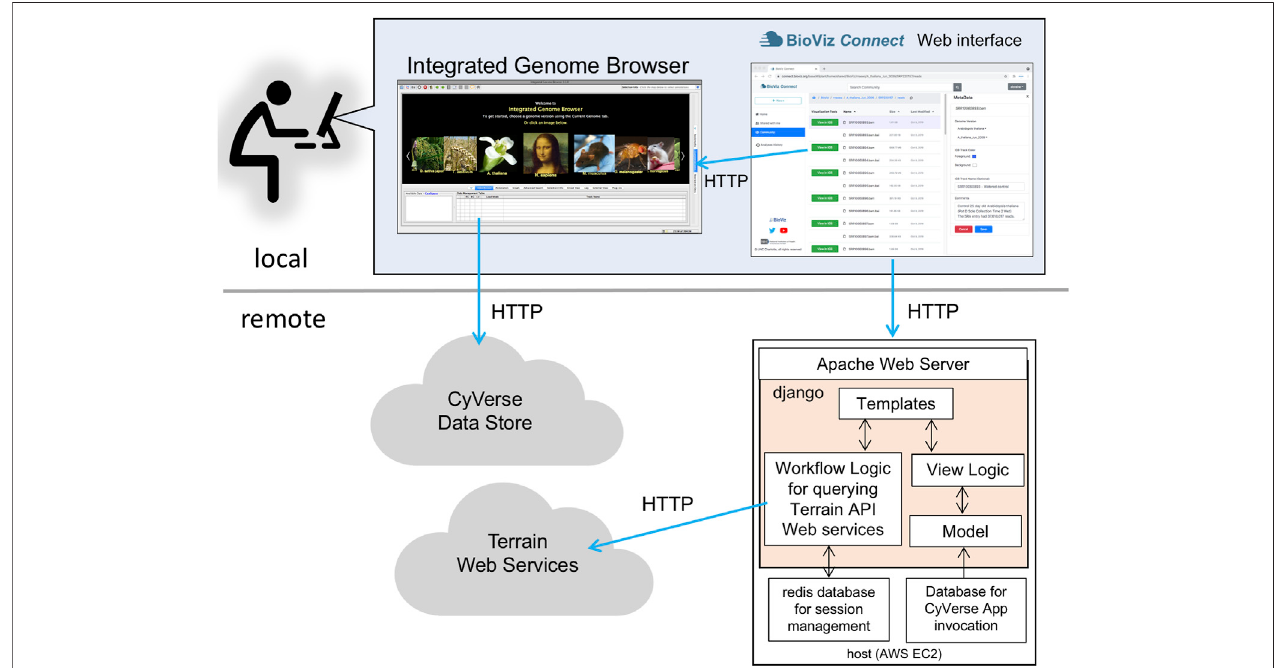
FIGURE 1 | Diagram illustrating local client and remote server-side design of BioViz Connect . After users log in using their CyVerse user credentials, the BioViz Connect Webinterfaceappears intheirWebbrowser.Clickingthe “ ViewinIGB ” button causesthebrowsertomakeHTTPrequeststoalocalhostREST endpointwithin IGB. These HTTP requests include information IGB uses to issue new HTTP requests for data resources. The BioViz Connect Web interface is populated via HTTP requests made to a remote host running the Apache Web server, which forwards these requests (using a reverse proxy mechanism) to the BioViz Connect